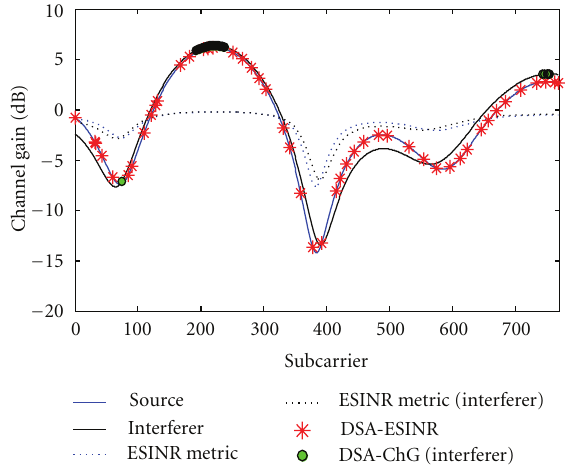
Figure 9: BER performance comparison between default and “forced” uncorrelated